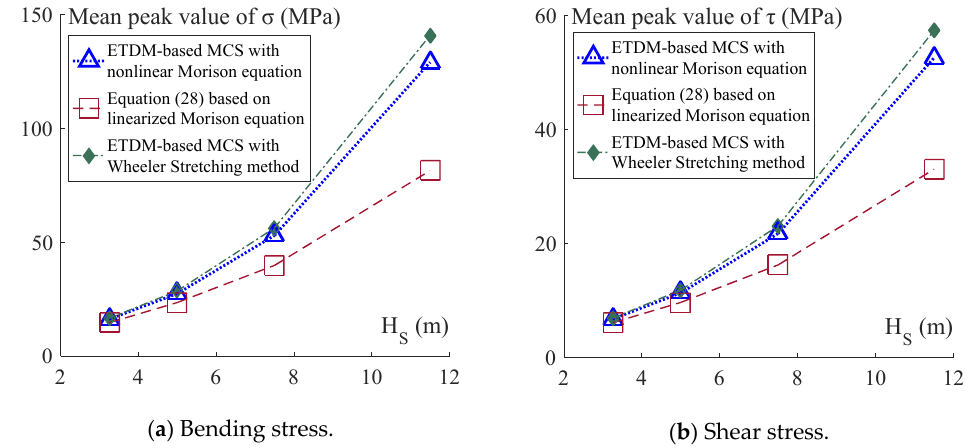
Figure 14. Mean peak values of the bending and shear stress at the bottom of a battered leg of the jacket platform.